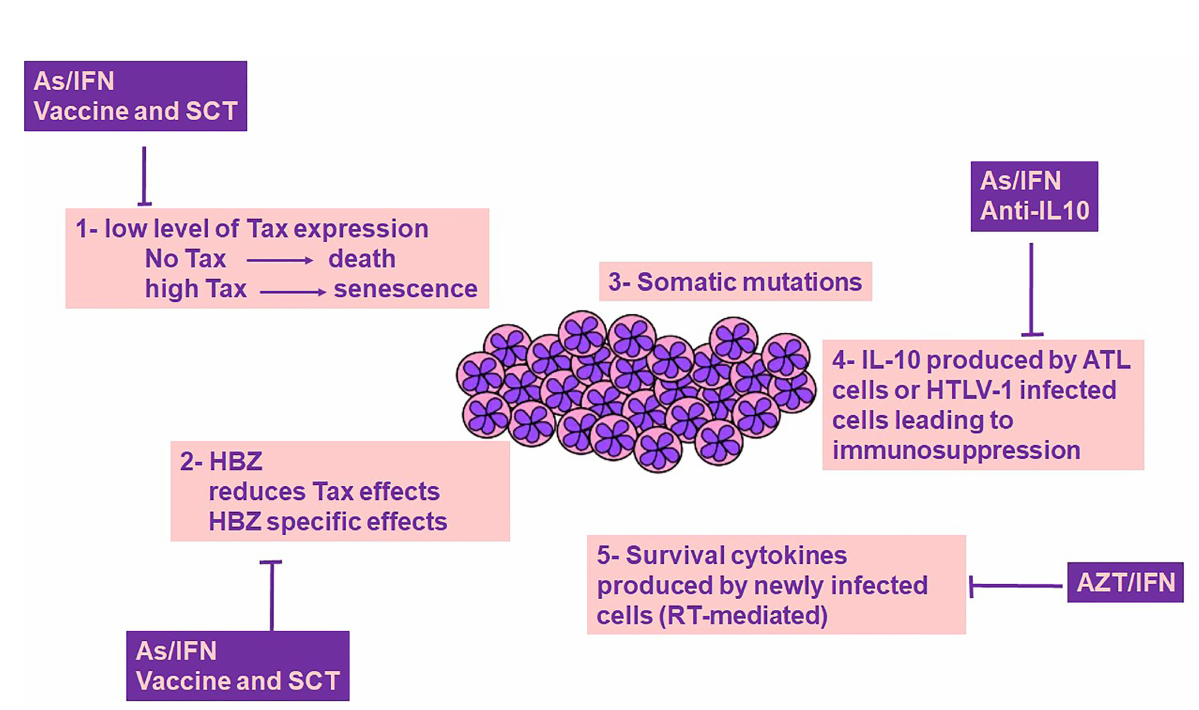
FIGURE 1 ATL cells survival: a cross-talk between genetics, viral proteins and immune-microenvironment. Survival of ATL cells requires Tax expression, yet Tax is highly immunogenic, and its expression at high levels drives senescence, a cellular fate counterbalanced by HBZ. Tax induced genetic instability results in the accumulation of somatic mutations. Both Tax and HBZ promote IL-10 expression, a key cytokine contributing to ATL cell survival and host immunosuppression. Newly infected T cells produce cytokines that contribute to the survival of ATL cells. The role of Tax/HBZ and IL-10 in ATL leukemogenesis highlights the importance of dual targeted therapies including anti-viral therapies and targeted therapies against viral oncoproteins and IL-10, as a promising curative avenue for ATL. AZT/IFN, Zidovudine and Interferon-alpha; As/IFN, Arsenic trioxide and Interferon-alpha; SCT, Stem Cell Transplantation; IL-10, Interleukin-10; RT, Reverse